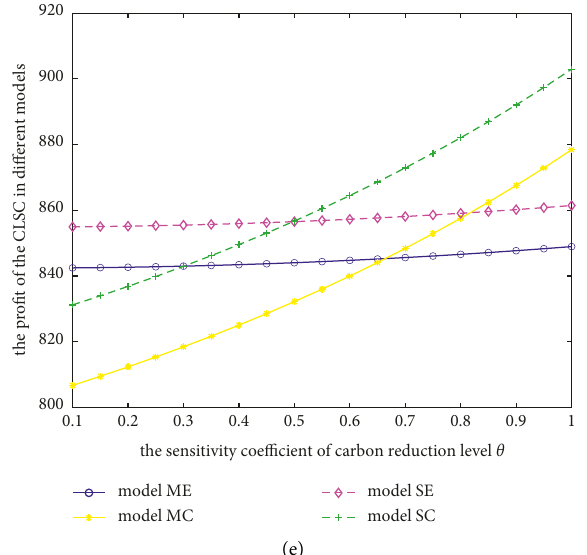
Figure 3: The sensitivity coefficient of carbon reduction level θ . (a) The capacity investment of manufacturing in different models. (b) The carbon reduction level in different models. (c) The profit of the supplier in different models. (d) The profit of the manufacturer in different models. (e) The profit of the CLSC in different